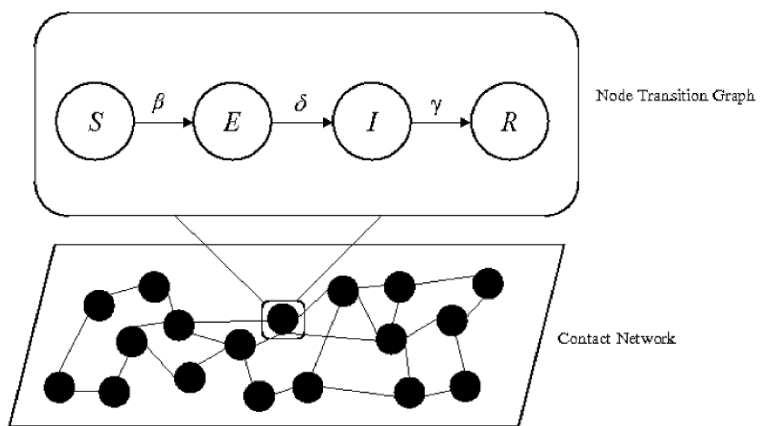
Fig 1. Diagram of an individual-based network model that consists of a node transition graph and a contact network. Circles in the node transition graph represent the four compartments susceptible (S) , exposed (E) , infectious (I) , and recovered (R) of a node (i.e., of an individual cow), and arrows between the compartments show the direction of transition for each node (cow) with rates driven by parameters β (transmission rate), δ (infectious rate), and γ (recovery rate). Circles in the contact network, in turn, represent individual cows (i.e., nodes), and black lines linking circles represent opportunities for RVFV transmission.